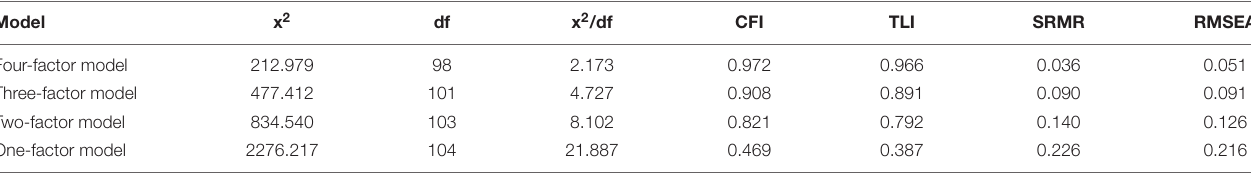
TABLE 1 | Confirmatory factor analysis (CFA) of measurement models.